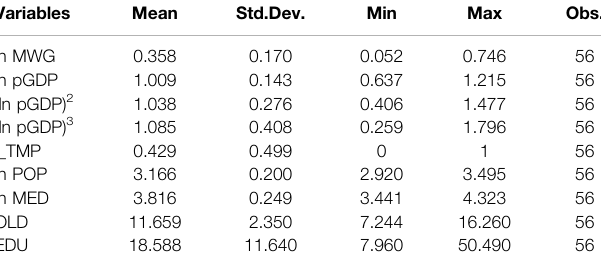
TABLE 3 | Summary statistics of